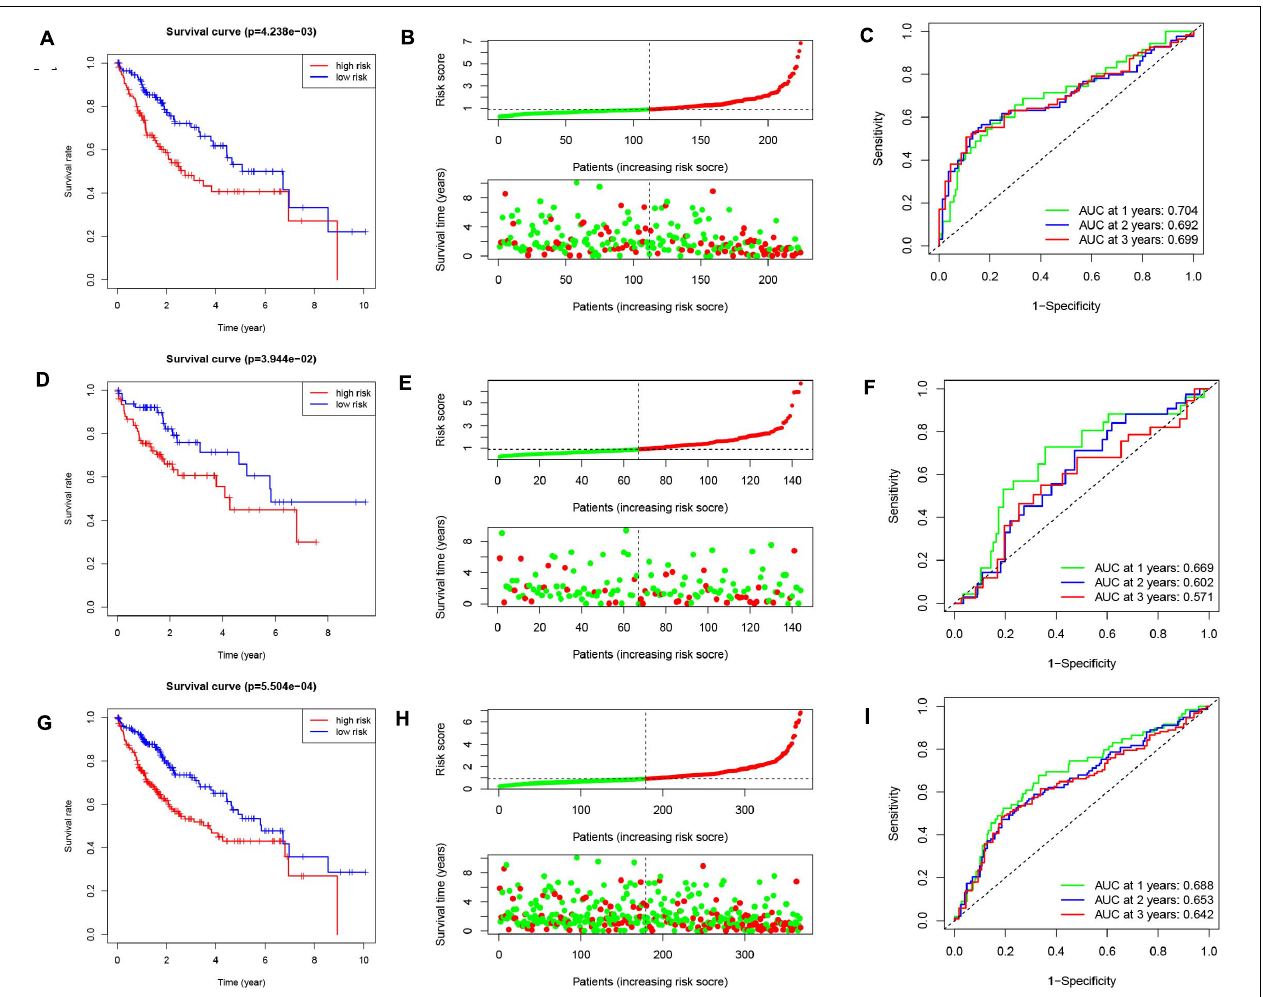
FIGURE 2 | Kaplan–Meier survival analysis, risk score analysis and ROC curve analysis. Kaplan-Meier survival curve, risk score, and ROC curve analysis of the immune-related eRNA signature were illustrated within the training cohort [ (A–C) , respectively], within the testing cohort [ (D–F) , respectively], and within the entire cohort [ (G–I) ,